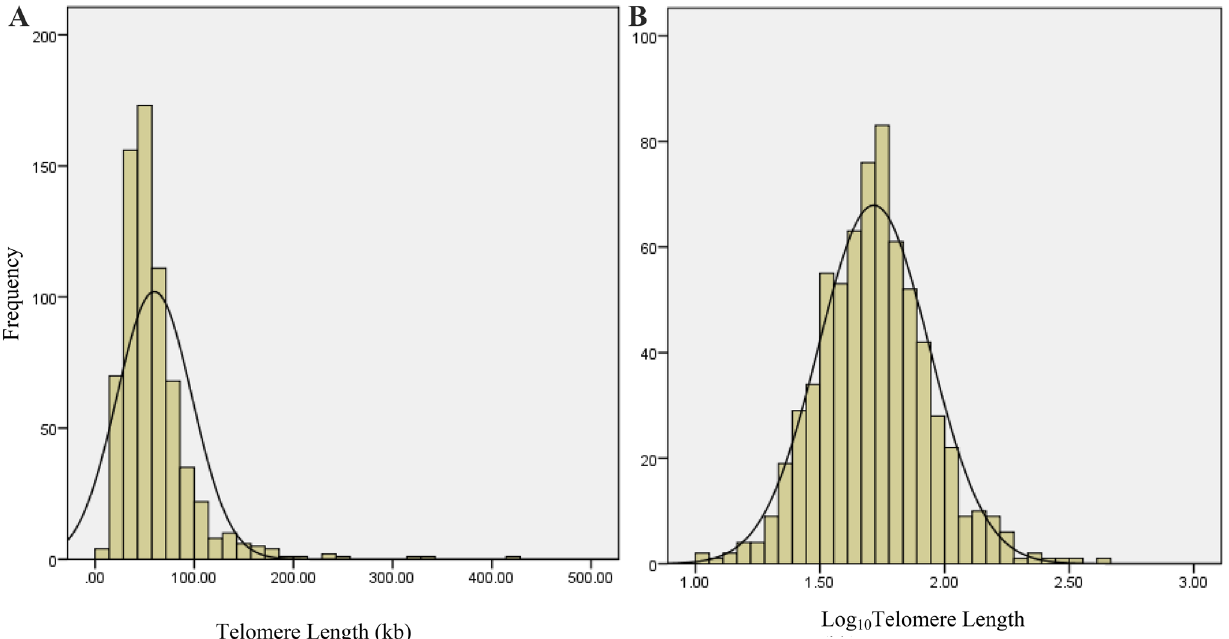
Figure 1. ( A ) Distribution of telomere length in the general population, ( B ) Distribution of Log 10 telomere length in the general